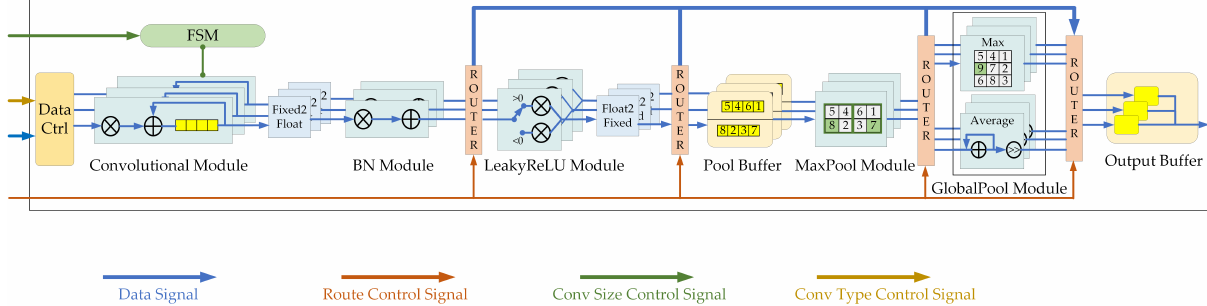
Figure 11. Reconfigurable processing engine